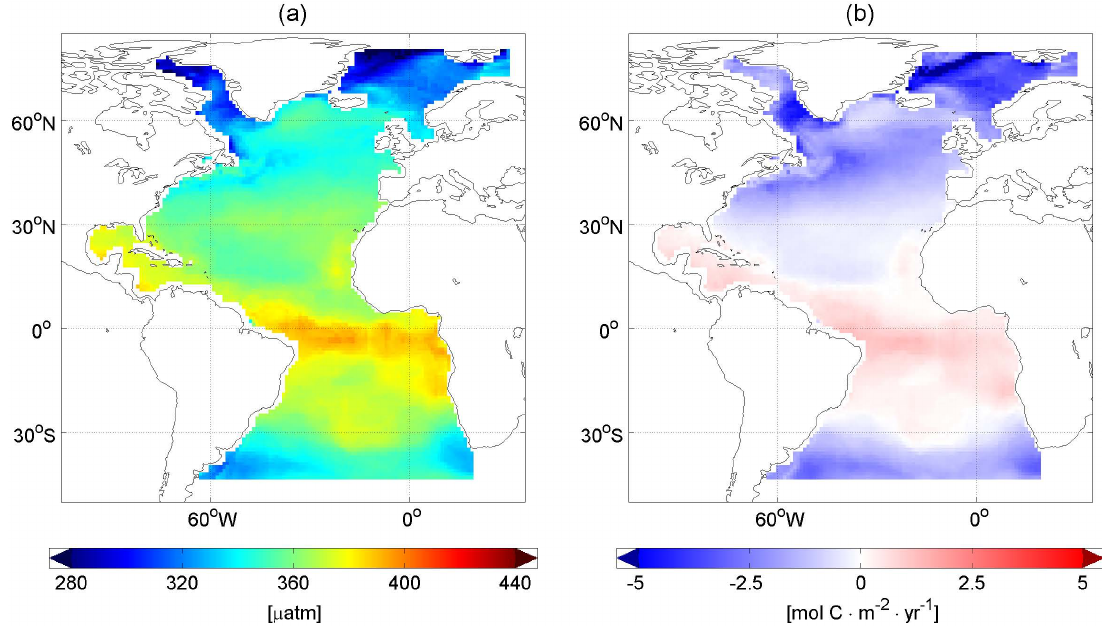
Fig. 6. (a) Decadal mean surface ocean p CO 2 and (b) CO 2 flux density in mol Cm − 2 yr − 1 for the Atlantic Ocean. Negative flux densities indicate CO 2 uptake by the